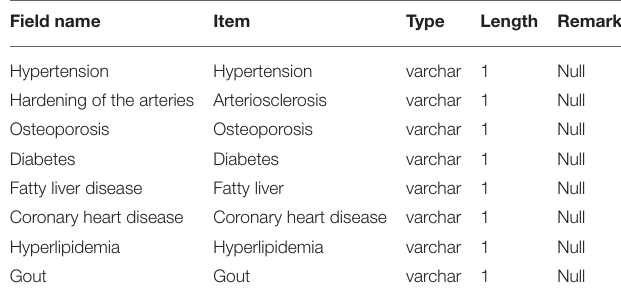
TABLE 4 | Structure on chronic disease